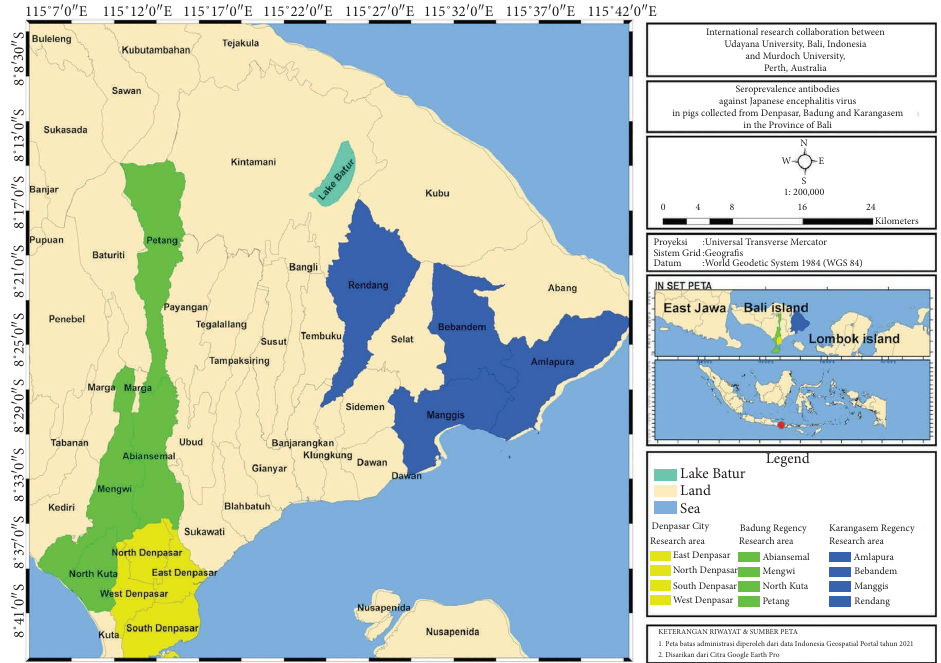
Figure 1: Map of selected sampling locations to estimate the seroprevalence of JEV in pigs from Denpasar city, Badung, and Karangasem regencies in the province of Bali,